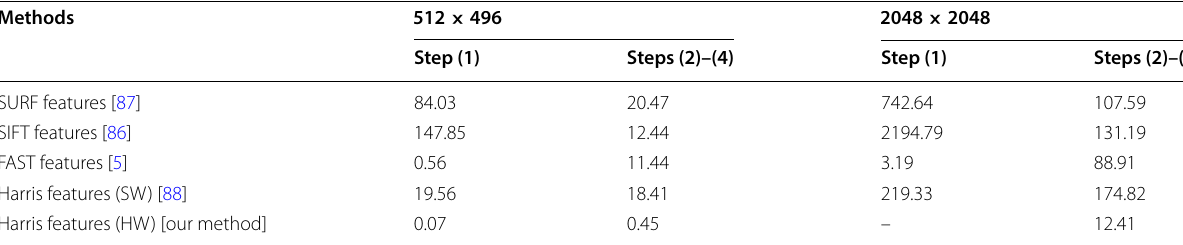
Table 2 Comparison in execution time (unit: ms) Methods